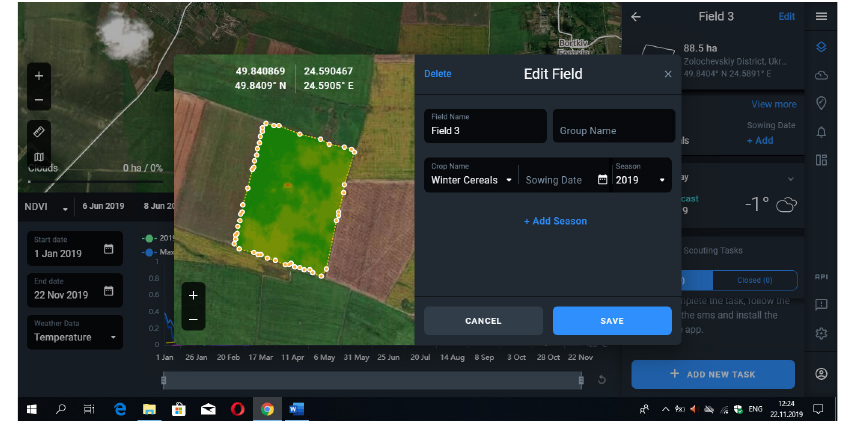
Figure 1. Display of the location of the study object in Crop Monitoring software according to the data of artificial satellite